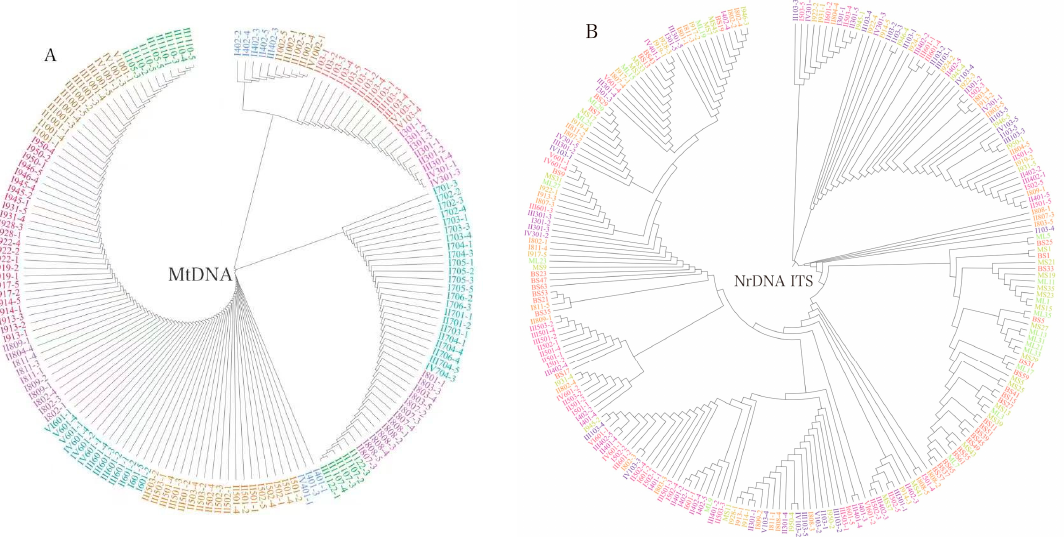
Figure 4. Phylogenetic relationships among individuals. ( A ) The mtDNA markers; ( B ) the nrDNA ITS markers. Individuals in different colors represent the origins of different populations.